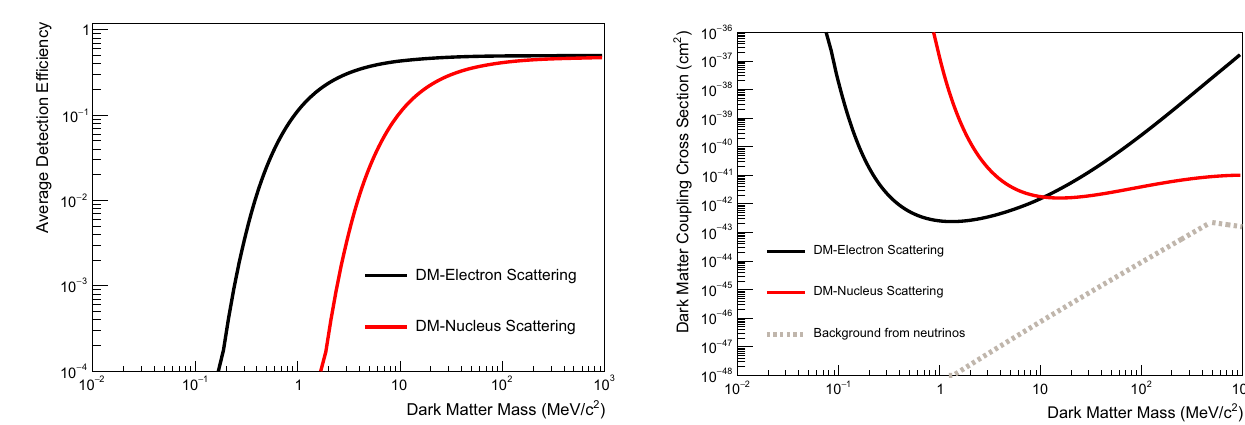
Fig. 11 Shown is the average detection efficiency, normalized to a phonon detection efficiency of 50%, for DM-nucleus and DM-electron interactions, as a function of the mass of DM